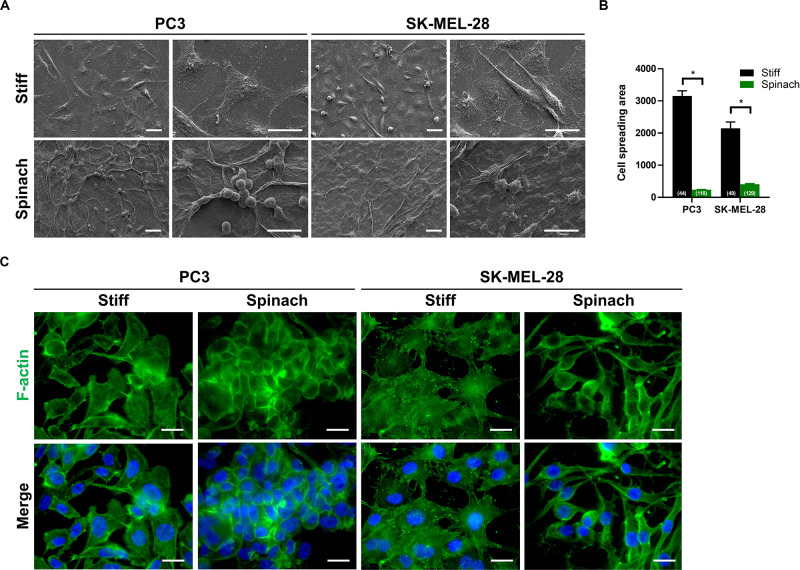
Cell culture on leaf scaffold induced cell morphology changes. (A) Representative SEM images of PC3 and SK-MEL-28 cells cultured on stiff substrate (coverslip) or spinach leaf scaffold for 3 days. The cell images were collected in three independent experiments (n = 3). Scale bars = 20 μm. (B) Histogram showing the changes of cell spreading area on stiff and leaf substrates and represented as mean ± SEM (n = 3, *p < 0.05; Mann-Whitney test). The numbers shown in parenthesis indicated cell numbers for statistics of cell spreading area examined in each case. (C) Immunofluorescence images of F-actin and nuclei (DAPI) in PC3 and SK-MEL-28 cells seeded on stiff substrate (coverslip) and spinach scaffold. Scale bars = 15 μm.